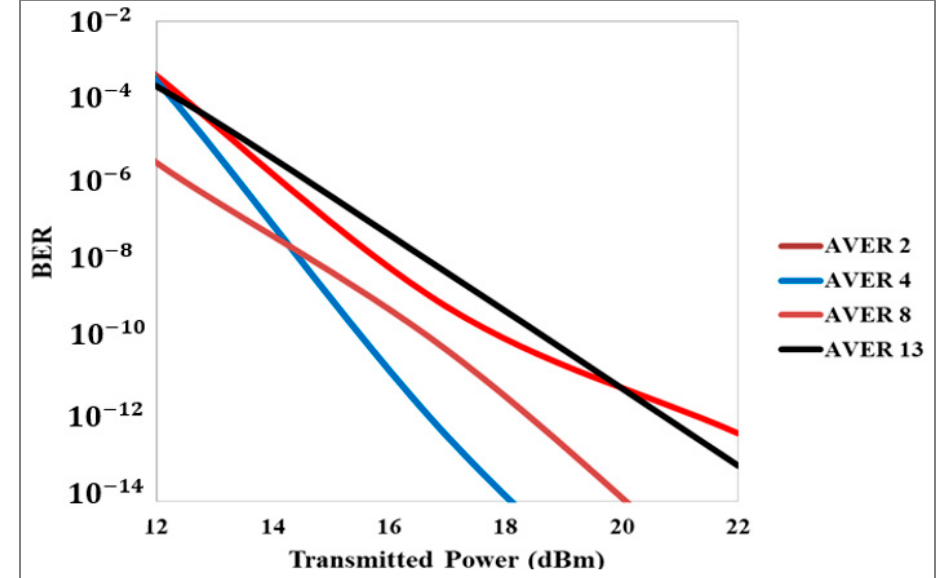
Figure 2. The Average BERs versus Transmitted Power for Four Random Channels (CSRZ).